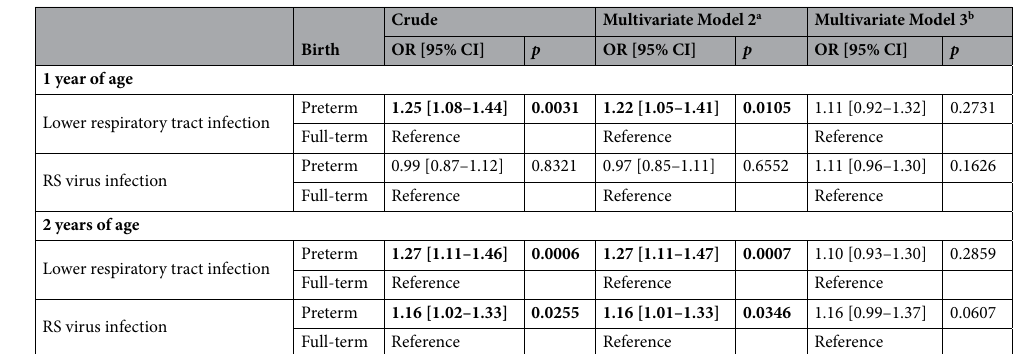
Table 3. Mediating effect of Palivizumab on RSV and lower respiratory tract infections in preterm infants. Boldface indicates significance. a Adjusted for maternal age, pre-pregnancy body mass index, parity, history of maternal allergy, history of any physical disease, marital status, employed, highest education level, annual household income, alcohol intake, smoking history, physical activity, feeding methods, and attending a childcare facility. b Adjusted for all the covariates in Model 2 and having received Palivizumab, a monoclonal antibody against the RSV. n = 62,731.